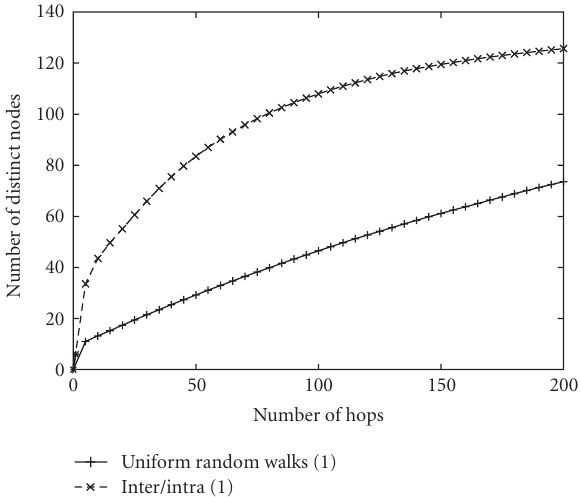
Figure 12: The number of distinct nodes discovered in the same group within a specific hop number.